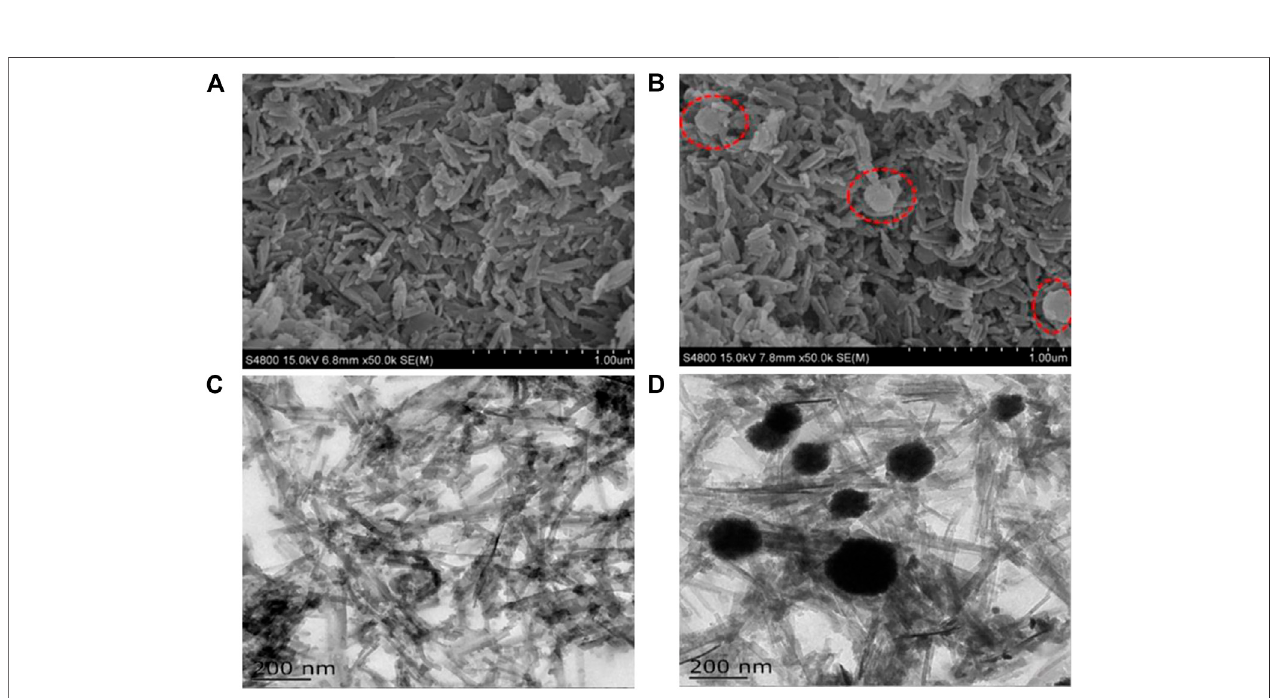
FIGURE 2 | SEM images of (A) MIL-53(Al)-NH 2 and (B) Fe 3 O 4 @MIL-53(Al)-NH 2 ; TEM images of (C) MIL-53(Al)-NH 2 and (D) Fe 3 O 4 @MIL-53(Al)-NH 2 .